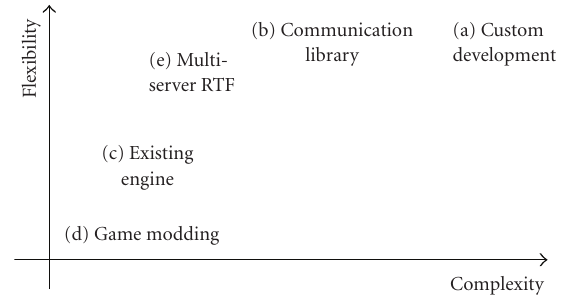
Figure 3: Taxonomy of game development approaches.